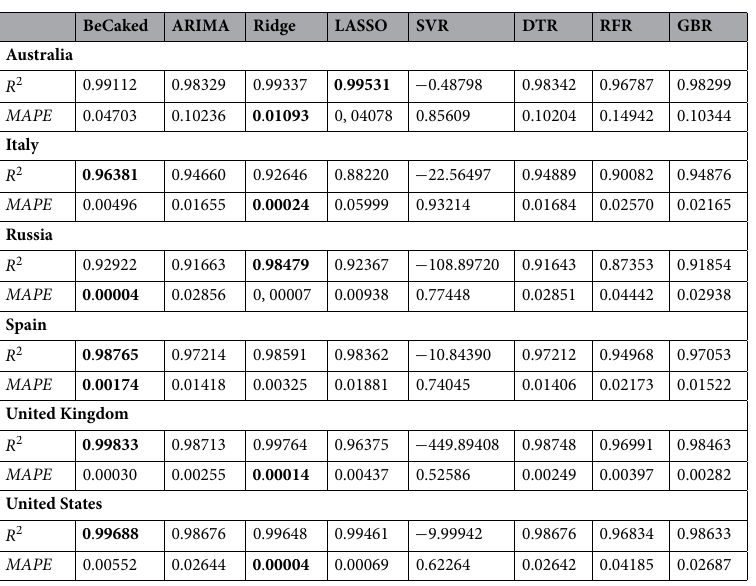
Table 4. Comparison of BeCaked and top-tier forecasting-specialized methods at country level with 1-step forecast. Best results are in [bold].